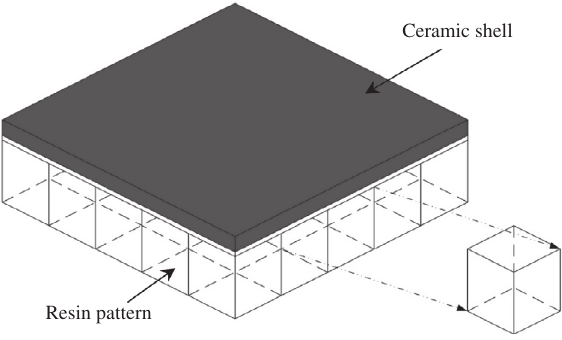
Figure 1. Ceramic-resin composite structure with single-layer periodic resin configuration.